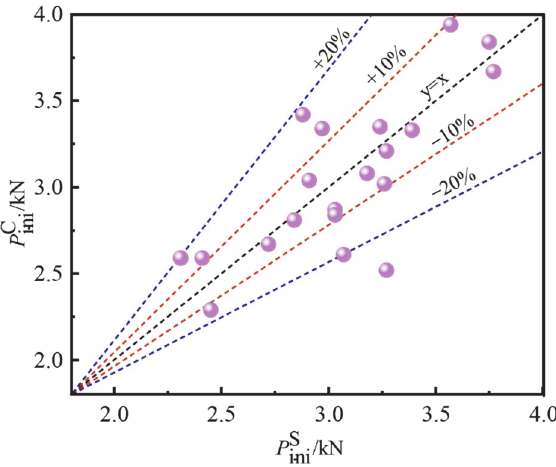
Figure 8. Comparison of the P ini value obtained by the test curve method and the strain gauge method.